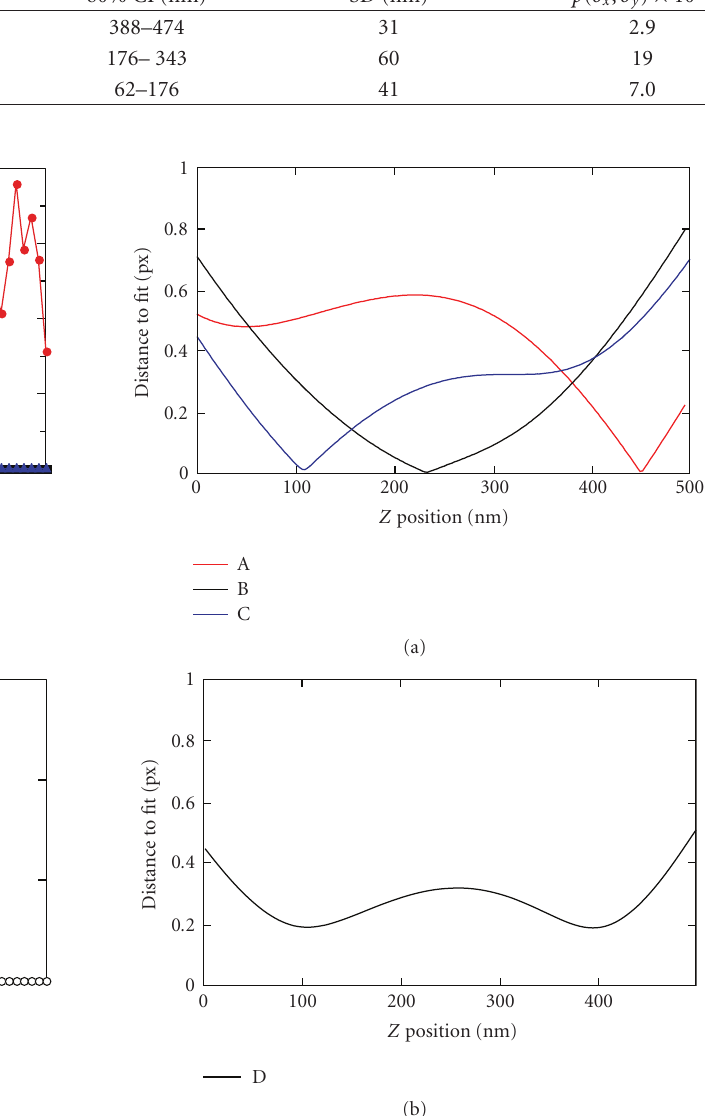
Figure 4: Distance plots using the method of Huang et al. [12] for points A–D using the calibration data displayed in Figure